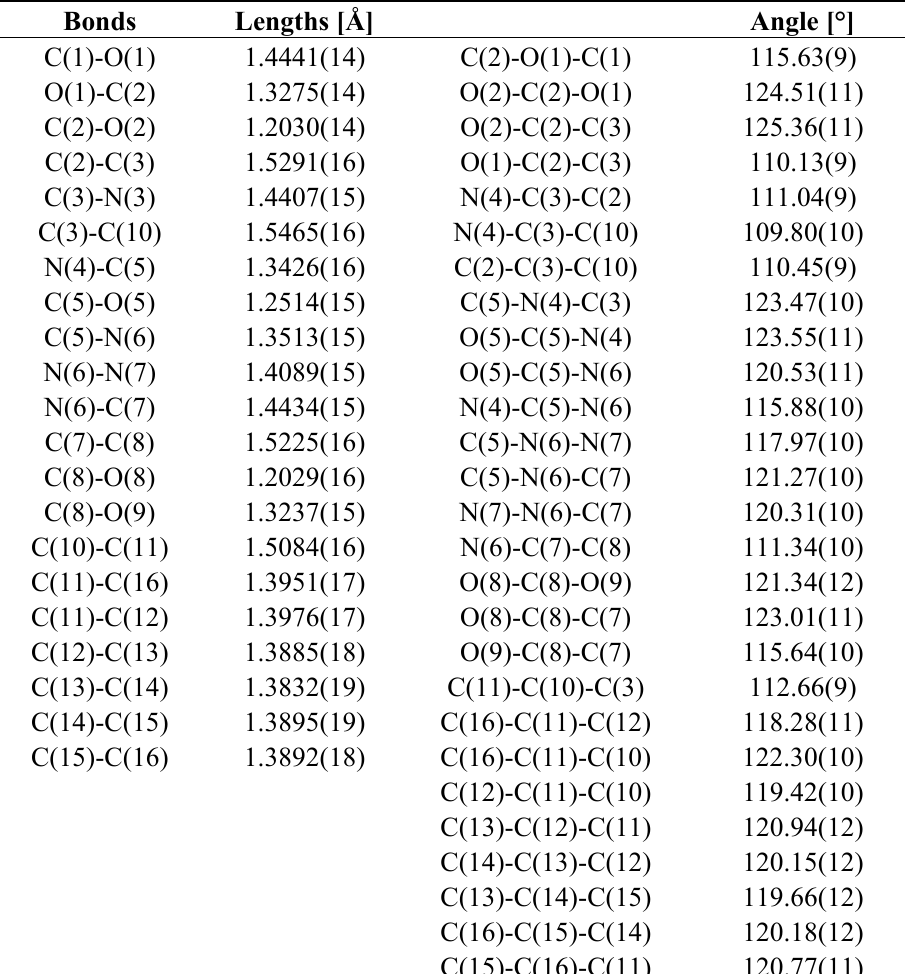
Table 1. Bond length and angles of 9 .